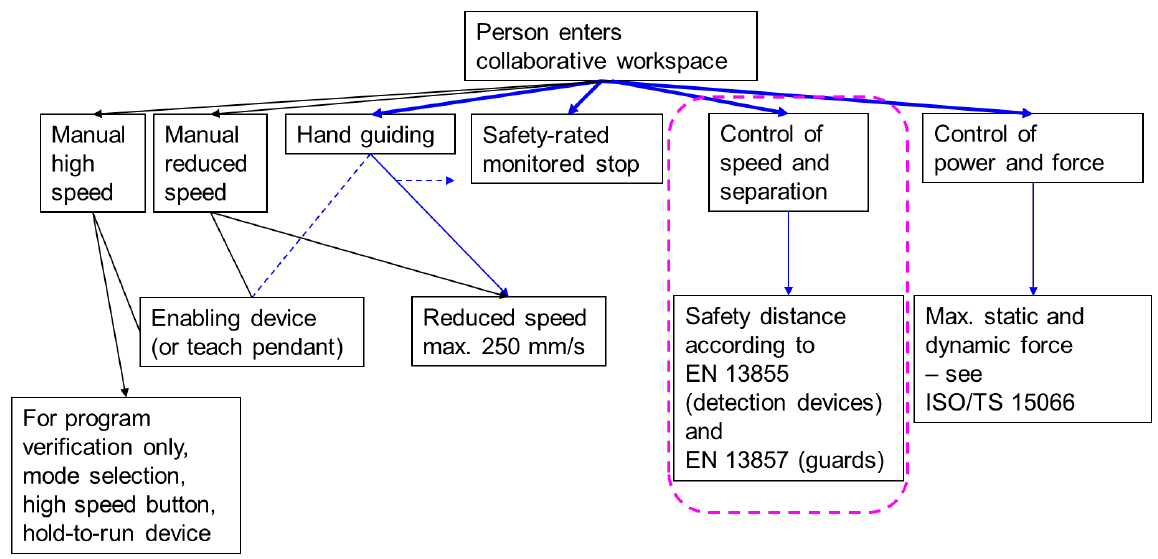
Figure 1: Collaborative and manual modes applied in collaborative